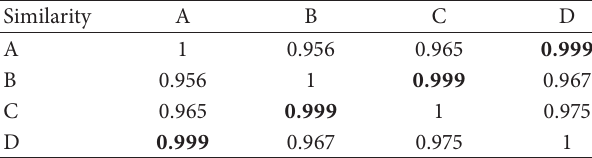
Table 3: Users’ similarity based on CM.